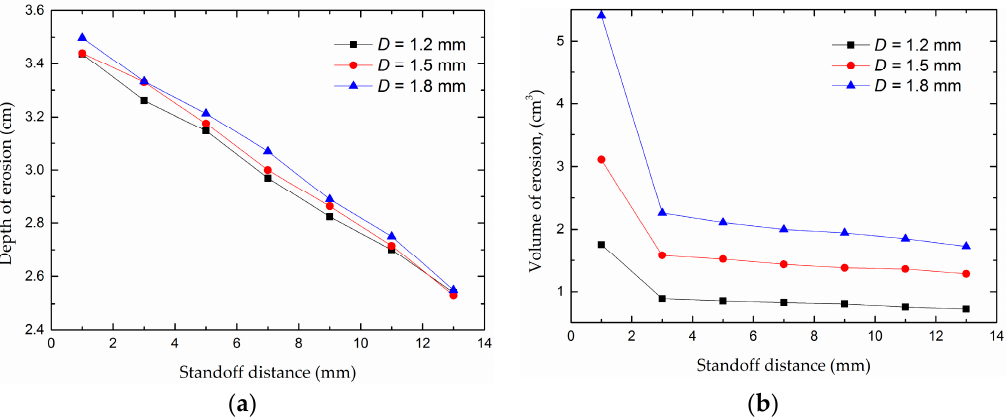
Figure 10. The erosion depth and the erosion volume with change in standoff distance. ( a ) Depth of erosion; ( b ) volume of erosion.